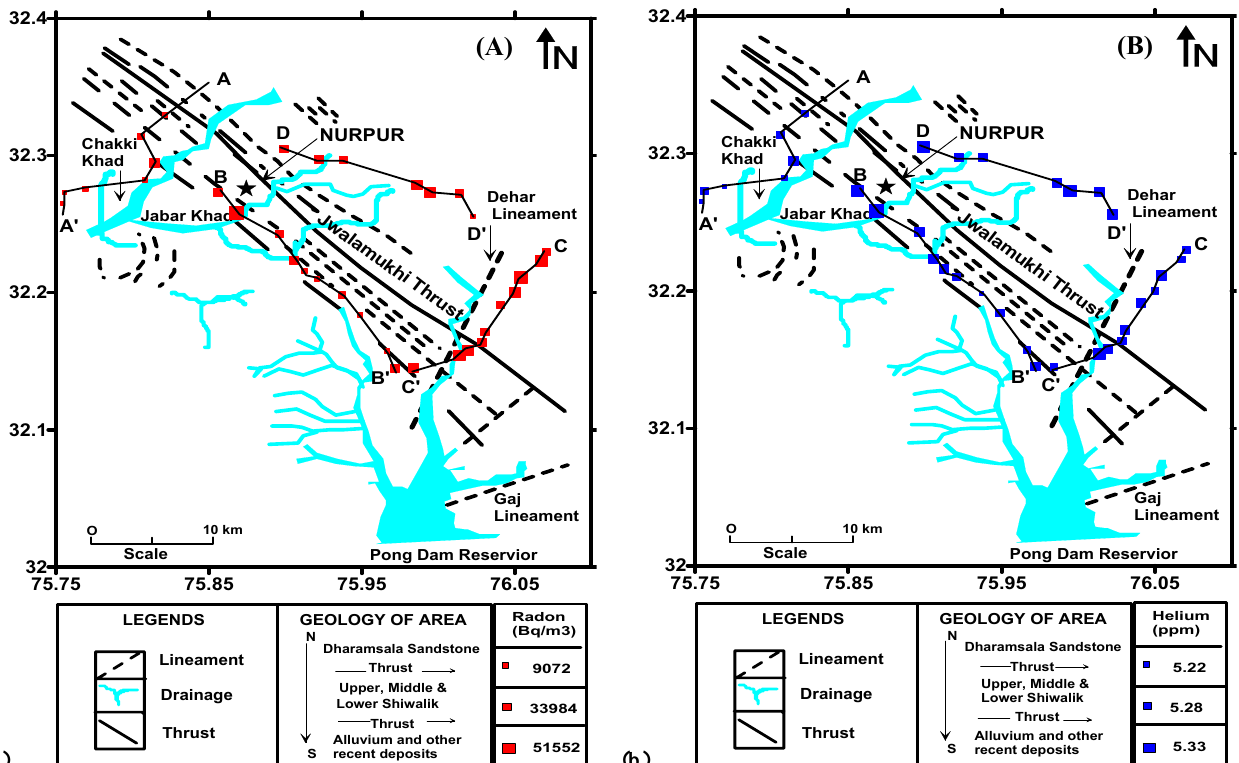
Fig. 3. Map of Nurpur and adjoining areas in the present study showing tectonic features (thrust, fractures, lineaments), drainage pattern (adapted from Singh et al., 2006) and the profile wise (A, B, C, and D) variation in (a) radon concentration. The size of solid red rectangles corresponds to radon concentration varying from 9 to 53kBq/m 3 . (b) helium concentration. The size of solid blue rectangles corresponds to helium concentration varying from 5.22 to 5.33ppm. (locally known as khad), and shows the highest value for radon (34 kBq/m 3 ) and helium (5.27 ppm). A1 and A2 al- though located very near to lineaments do not show anoma- lous values of either of the gases. This shows that not all the lineaments are geochemically active. Ten sampling loca- tions in Profile B are taken longitudinal to the major thrust in the study area i.e., Jawalamukhi thrust. Radon concentration ranges from 14 kBq/m 3 (B6) to 52 kBq/m 3 (B2) and helium shows variation from 5.2 ppm (B7) to 5.33 ppm (B2). The average radon and helium values recorded along this profile are 21 kBq/m 3 and 5.27 ppm, respectively. Higher